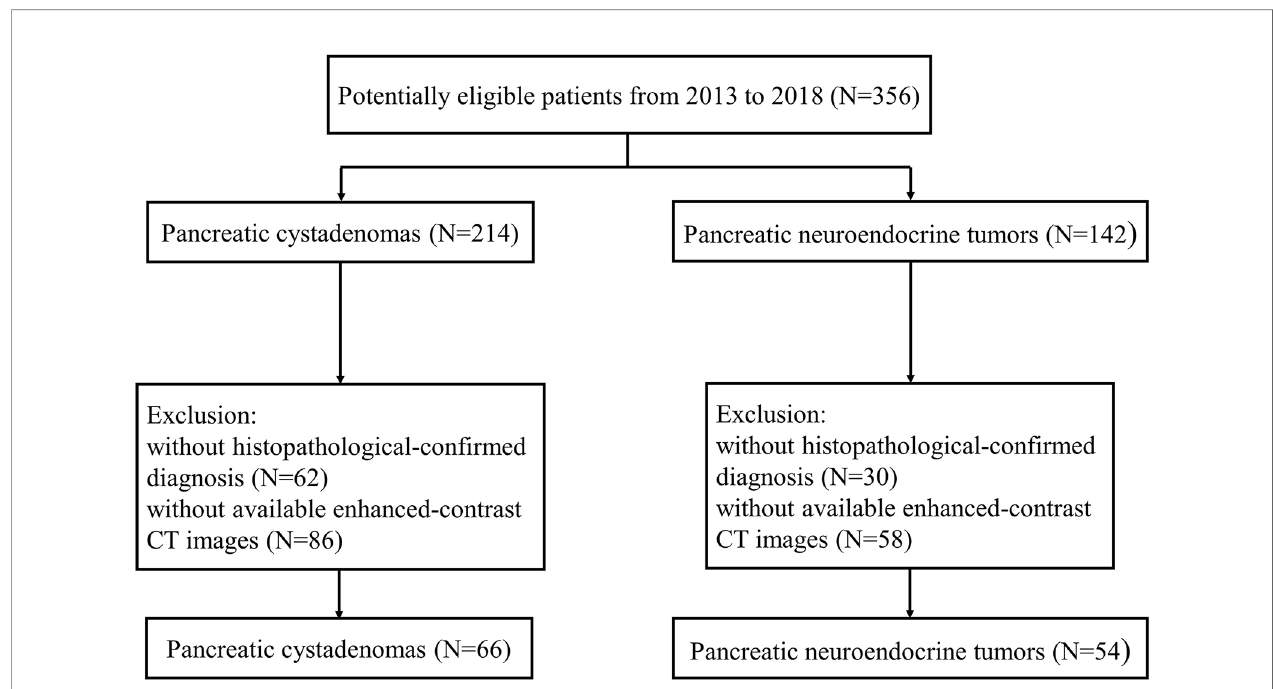
FIGURE 1 | Flowchart shows selection of study population and exclusion criteria.